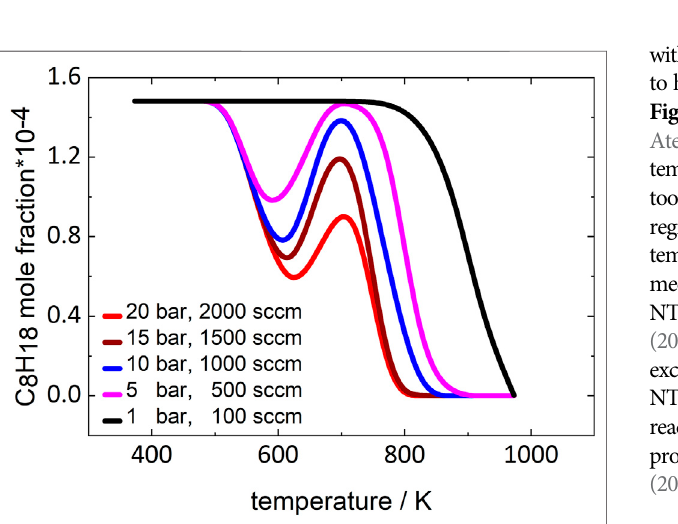
Figure 1 . All mechanisms used in this work, beside the mechanism of